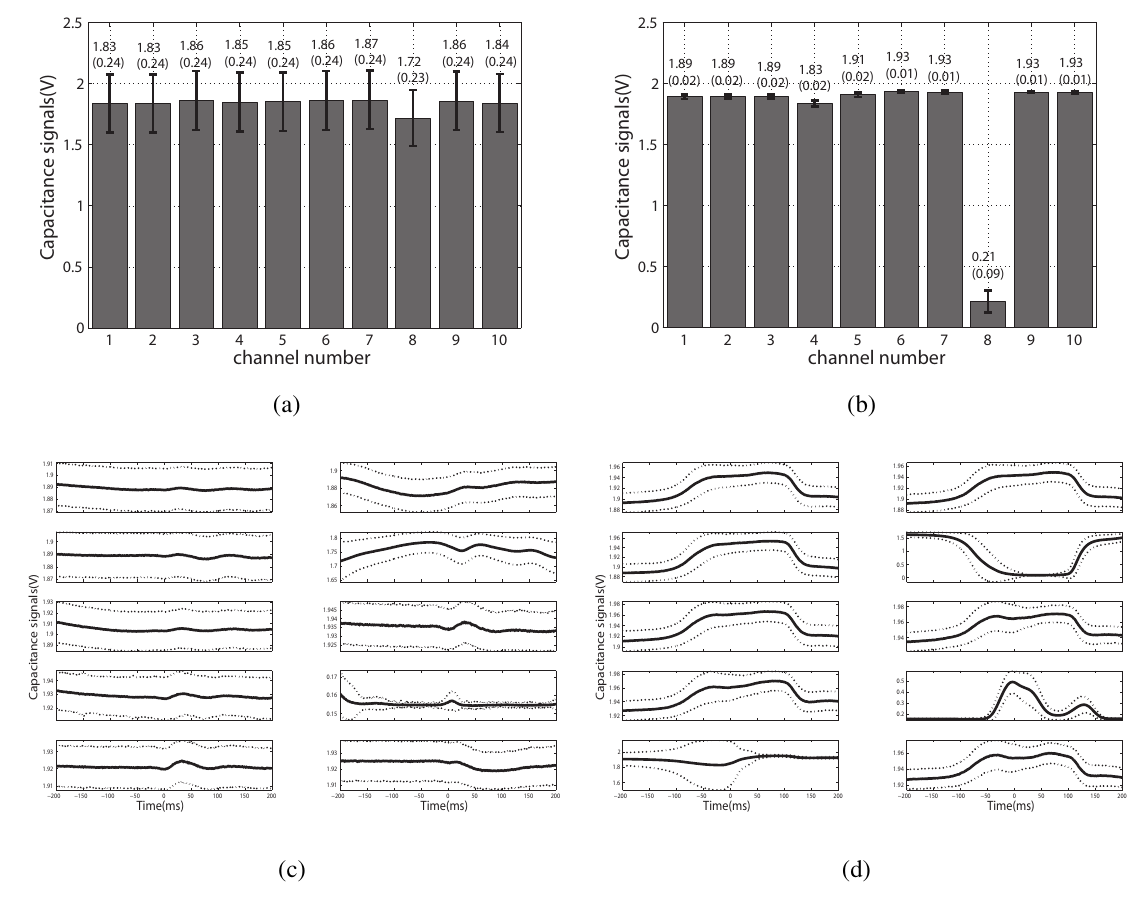
Figure 4. Continuous working stability of the capacitive system. ( a ) and ( b ) show the error bar of the capacitance signals of sitting and standing, respectively. The numbers on each bar represent the average voltage and its standard deviation; ( c ) and ( d) demonstrate the average signals (solid lines) of four phases and the variation (dotted lines) over different gait cycles of normal walking. The zero point on the x-axis indicates the gait event, FC and FO, respectively. The data shown in (c) was Pre-FC and Post-FC, with a duration of 200 ms in each phase, while in (d), the data was Pre-FO and